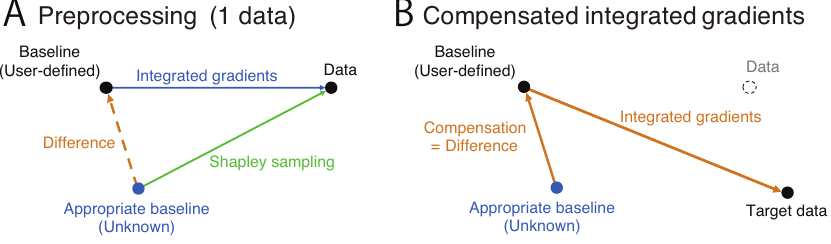
Figure 1. Diagram of the proposed method. ( A ) Preprocessing to compute the compensation amount (orange dashed arrow), given as the difference between the contribution to the classification obtained using the IG method with an arbitrary user-defined baseline (blue arrow) and the contribution to the classification obtained using the SS method that implicitly exhibits an appropriate baseline (green arrow). ( B ) Proposed IG method that compensates for the divergence from the appropriate baseline. This is equivalent to the path integral along the orange